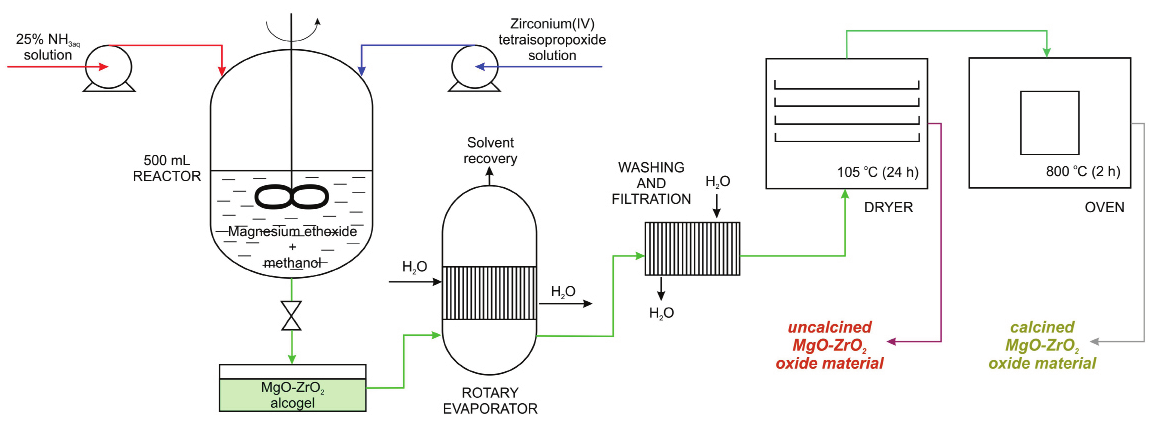
oxide materials. 2